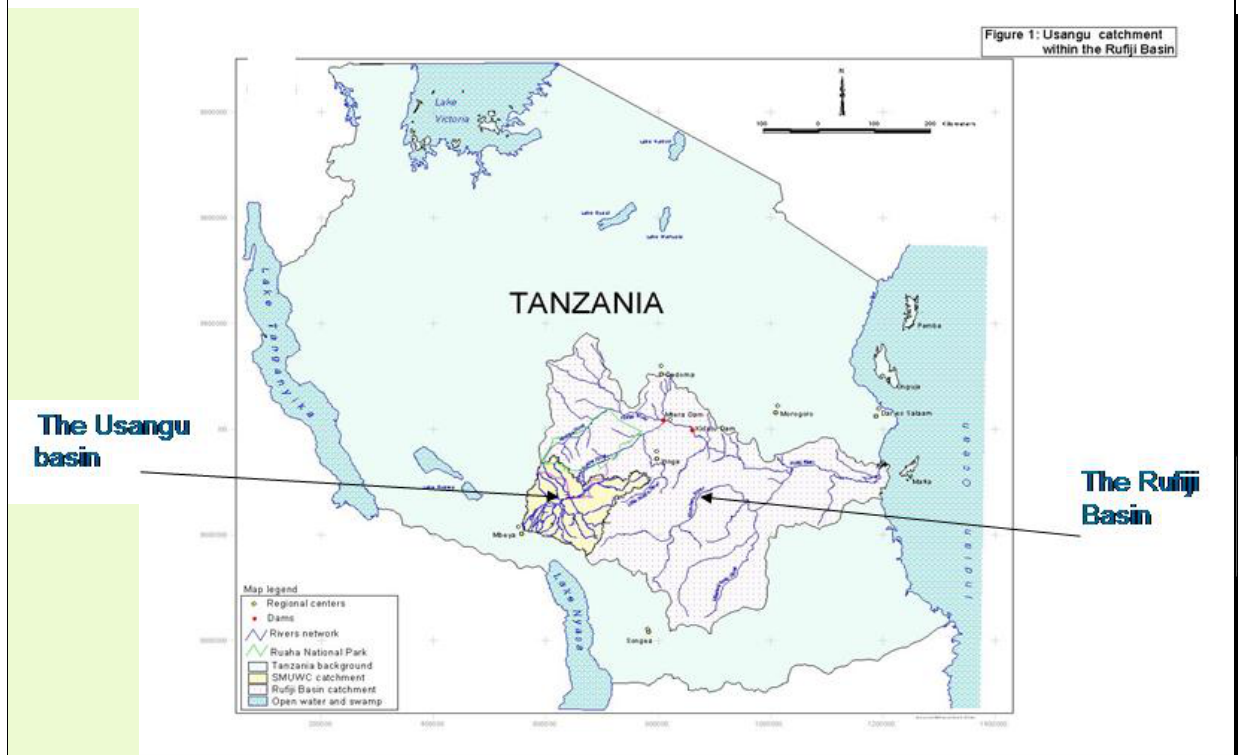
Figure 1: Map of Tanzania showing the Usangu Basin within the Rufiji River